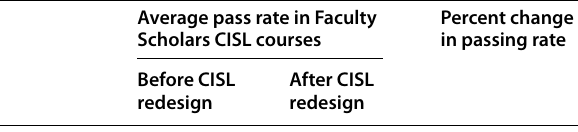
Table 5 CISL Program treatment effect on course passing rate Average pass rate in Faculty Percent change Scholars CISL courses in passing rate Before CISL After CISL redesign